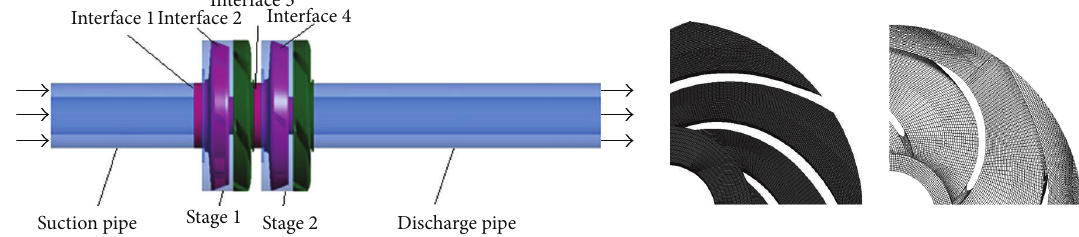
Figure 8: Dual-stage calculation model and numerical grids.